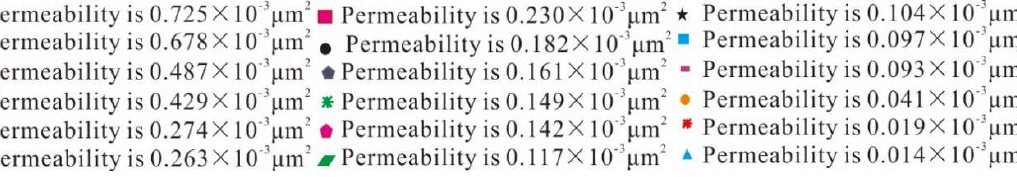
Figure 10. Relationship between gas saturation and pressure gradient of low-permeability sandstone in Sulige gas field.